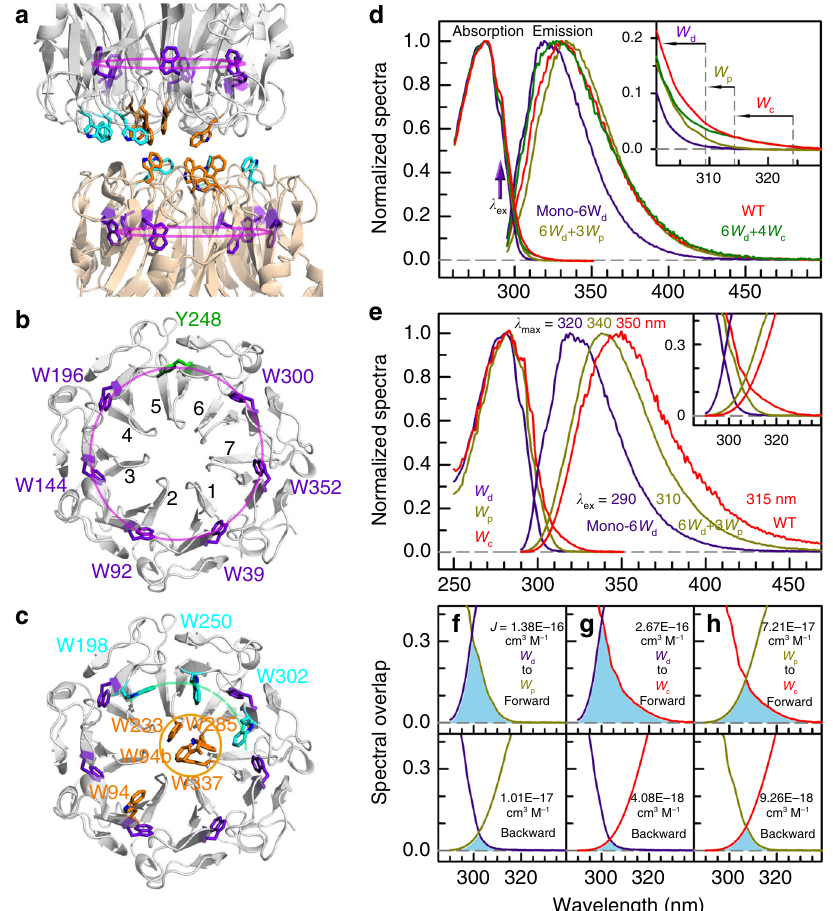
Fig. 1 UVR8 light-harvesting tryptophan networks and their steady-state spectra. a A side view of UVR8 dimer with three groups of W residues highlighted in different colors: 6W d , purple; 3W p , cyan; and 4W c , orange. 3W p and 4W c lie at the dimer interface whereas 6W d are buried in the middle of β sheets. b A top view of one subunit from the dimer interface shows the highly symmetrical ring locations of 6W d (W39, W92, W144, W196, W300, and W352). c A top view from the dimer interface displays the relative positions of the pyramid center (W337, W285, W233, and W94b) and the 3W p peripheral outlier (W302, W250, and W198). d Normalized absorption and emission spectra for UVR8 WT (red), 6W d + 4W c (green), 6W d + 3W p (dark yellow), and mono-6W d (purple). The inset highlights absorption differences beyond 300-nm wavelength. e Normalized absorption and emission spectra for 6W d (purple), 3W p (dark yellow), and 4W c (red). The inset shows a close view of the absorption – emission overlap region. Note the different excitation wavelengths for selected W groups; 290 nm for 6W d , 310 for 3W p , and 315 nm for 4W c . f – h Spectral overlap integrals for W d -to-W p ( f , top), W d -to-W c ( g , top), and W p -to-W c ( h , top) energy transfer. The corresponding reverse transfer is shown at the bottom of each panel. The overlap regions are shaded by light blue color. Note that the forward J refers W d to W p and W c or W p to W c , while the backward J refers W p to W d , W c to W d and W p